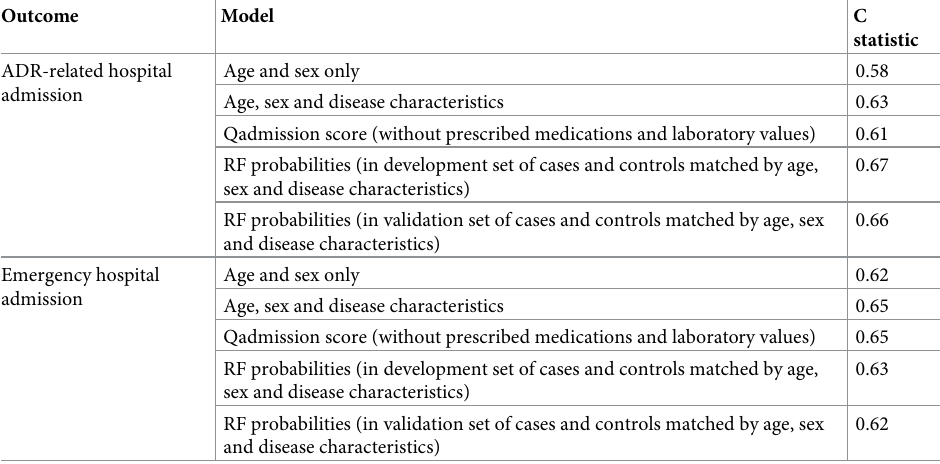
Table 3. Discrimination of different logistic models for ADR-related and emergency hospital